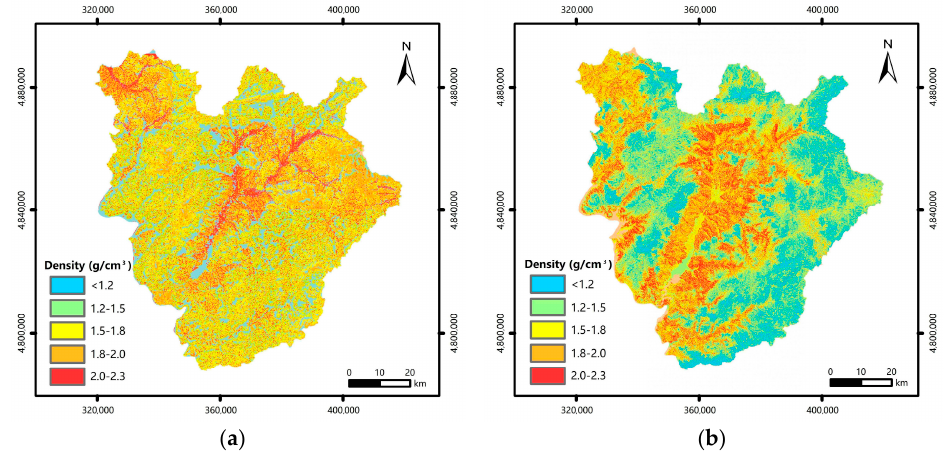
Figure 12. The predicted density of the water-soil mixture : ( a ) S-CN method ( b ) T-CN